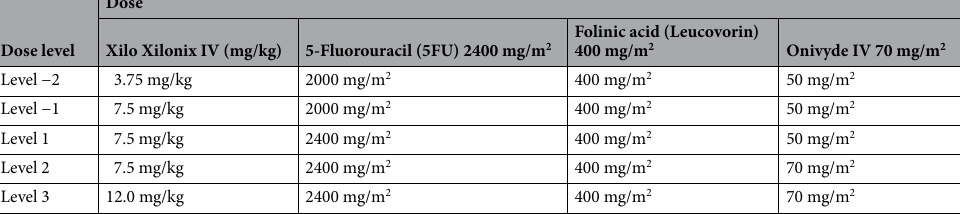
Table 1. Dose escalation